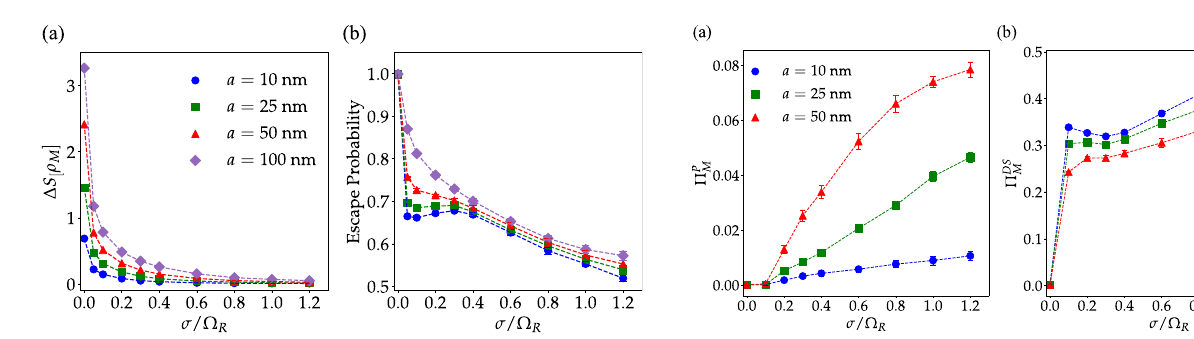
Fig. 4 Energetic disorder effect on entropy gained by molecular LDOS and escape probability of molecular excited-states. a Entropy gained by the molecular LDOS upon strong coupling with a photonic wire as a function of σ / Ω R for varying intermolecular distances (molecular density) with fi xed Ω R and vanishing detuning E C − E M = 0. In all computations, N = N σ μ = 0.05, and f = 0.1. Other parameters are given in the μ / M C , 0 text (see Thermodynamic limit convergence). b Molecular excited-state escape probabilities for the same systems. Each point corresponds to an average obtained over 20 disorder realizations (error bars indicate standard